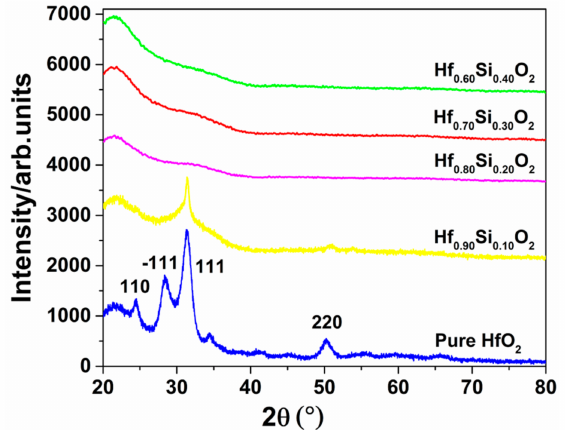
Figure 4. X-ray diffraction (XRD) spectra of the Hf 1 − x Si x O 2 nanocomposites with different SiO 2 contents.